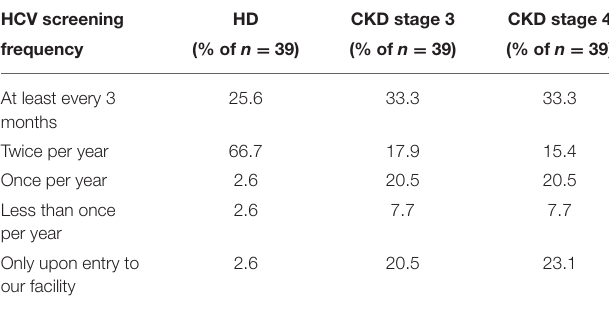
TABLE 13A | Frequency of screening for HCV, by ESKD stage (China Medical Director HCV survey,